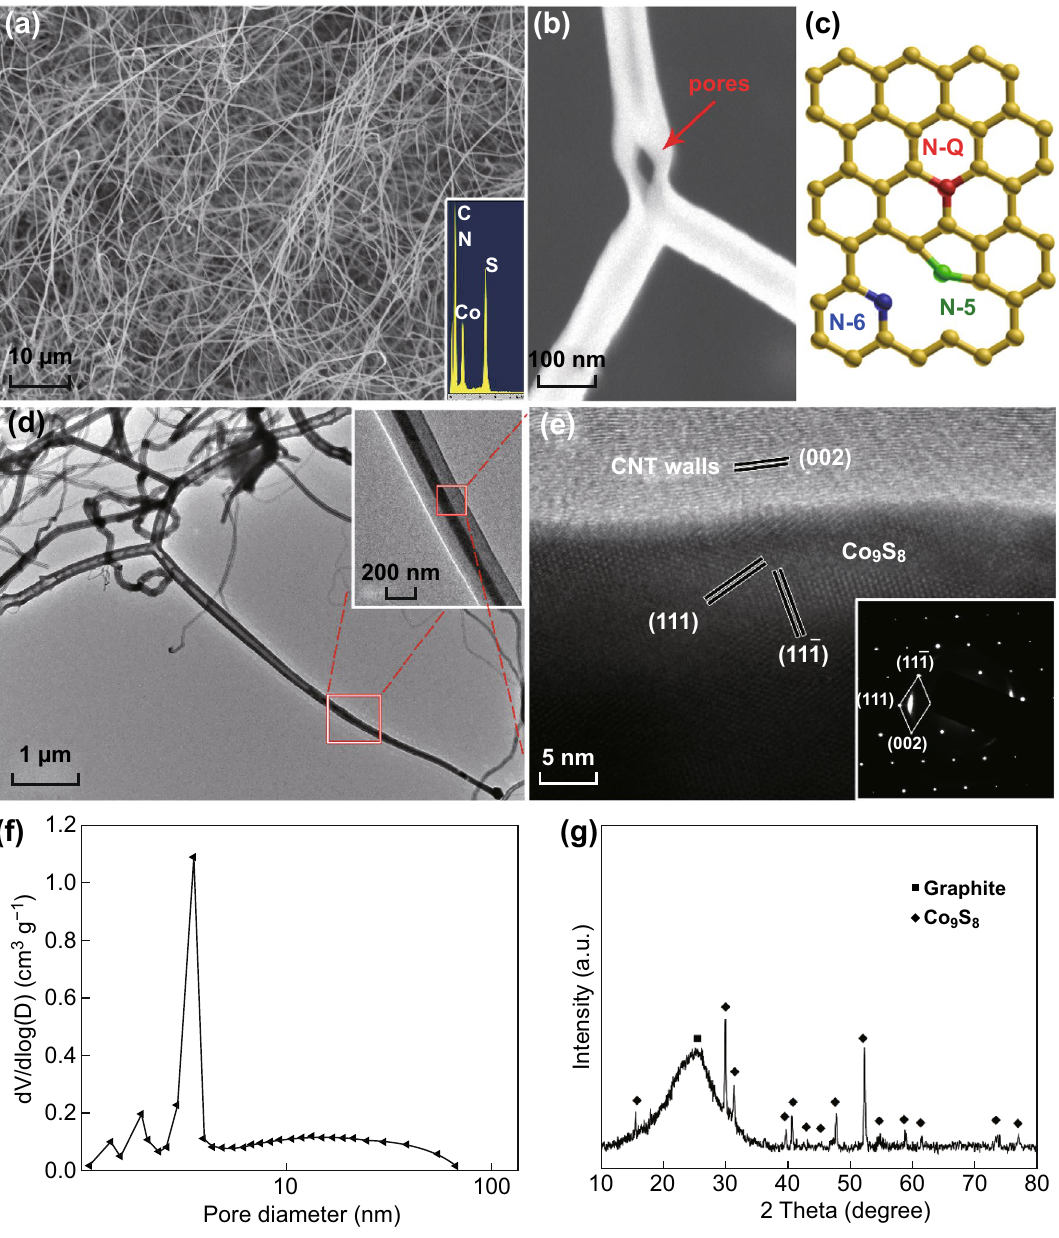
Fig. 2 a SEM image and corresponding EDX spectra of Co 9 S 8 @NBNT. b High‑magnification SEM images of Co 9 S 8 @NBNT. The porous structures are indicated by arrows. c Schematic diagram of N‑doped CNTs. d TEM image of Co 9 S 8 @NBNT. Inset is HRTEM image of the boxed area. e Enlargement of the boxed area shown in d and its corresponding SAED pattern (inset). f Pore‑size distributions. g XRD spectra of